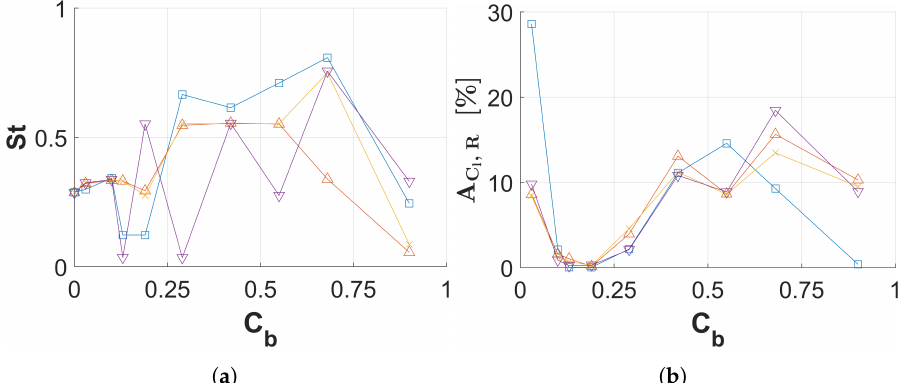
= A C l / A C l , NB , l , R